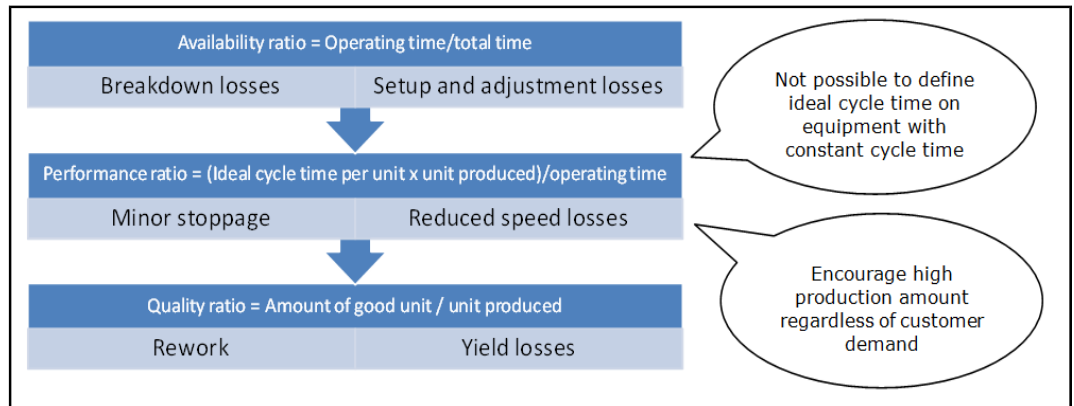
Figure 1. Calculation of performance ratio in traditional OEE